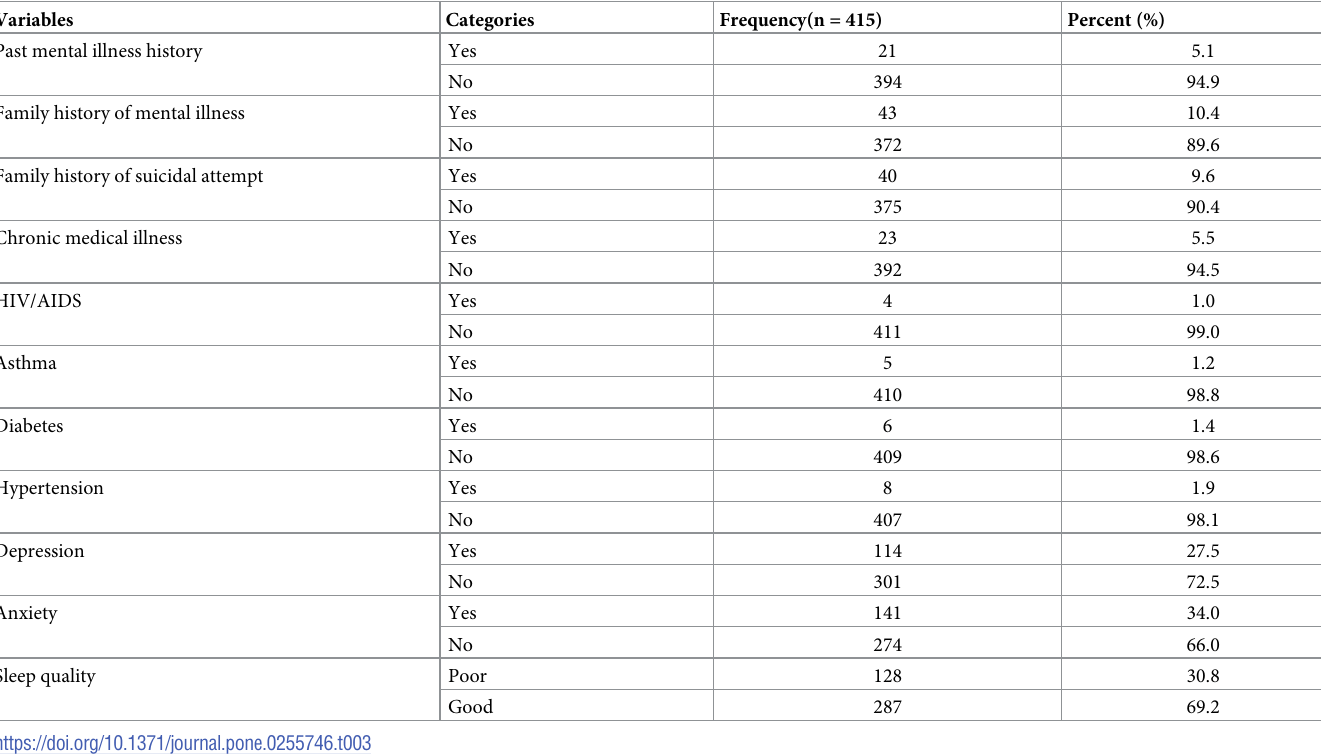
Table 3. Description of clinical related factors among pregnant women attending antenatal care at Jimma medical center, Jimma, Southwest, Ethiopia, 2020 (n = 415).